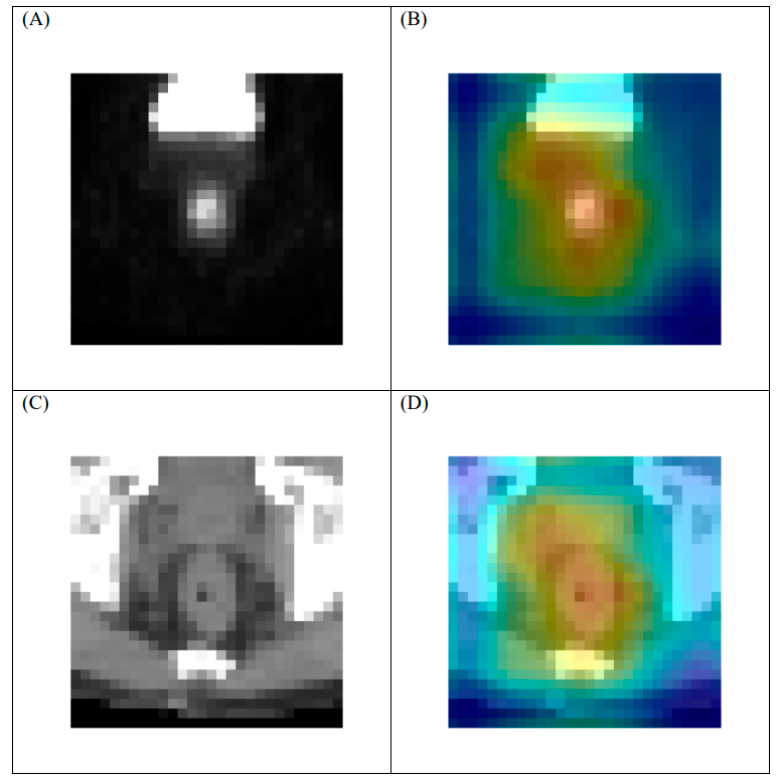
Figure 5. Representative heat map of tumor with regression grade 3 response on [F18]FDG-PET/CT in last layer of proposed model. ( A ) original PET, ( B ) heat map of PET, ( C ) original CT, and ( D ) heat map of CT. Note: 1. Heat maps were generated using a commercial software (Grad-CAM). 2. The geographical center of the PET and CT images is the same.